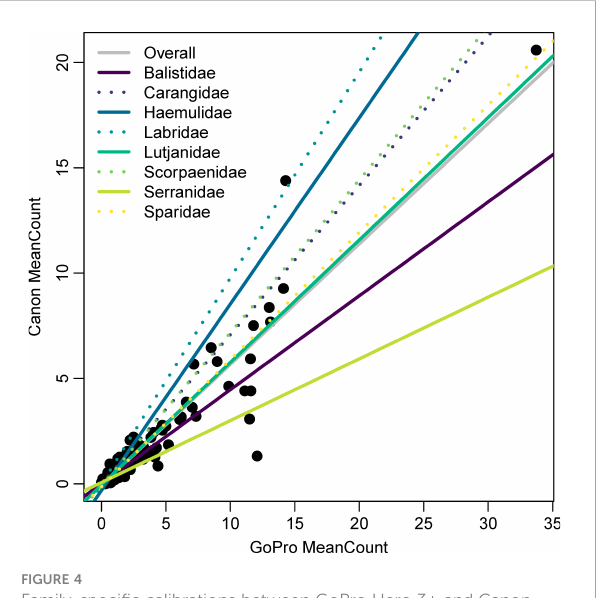
FIGURE 4 Family-speci fi c calibrations between GoPro Hero 3+ and Canon Vixia HF-S200 cameras from data collected by the Southeast Reef Fish Survey along the southeast United States Atlantic coast in 2014. The overall relationship was estimated using data across all families. Trendlines were estimated using a linear model fi t to data across all species within each of the eight families